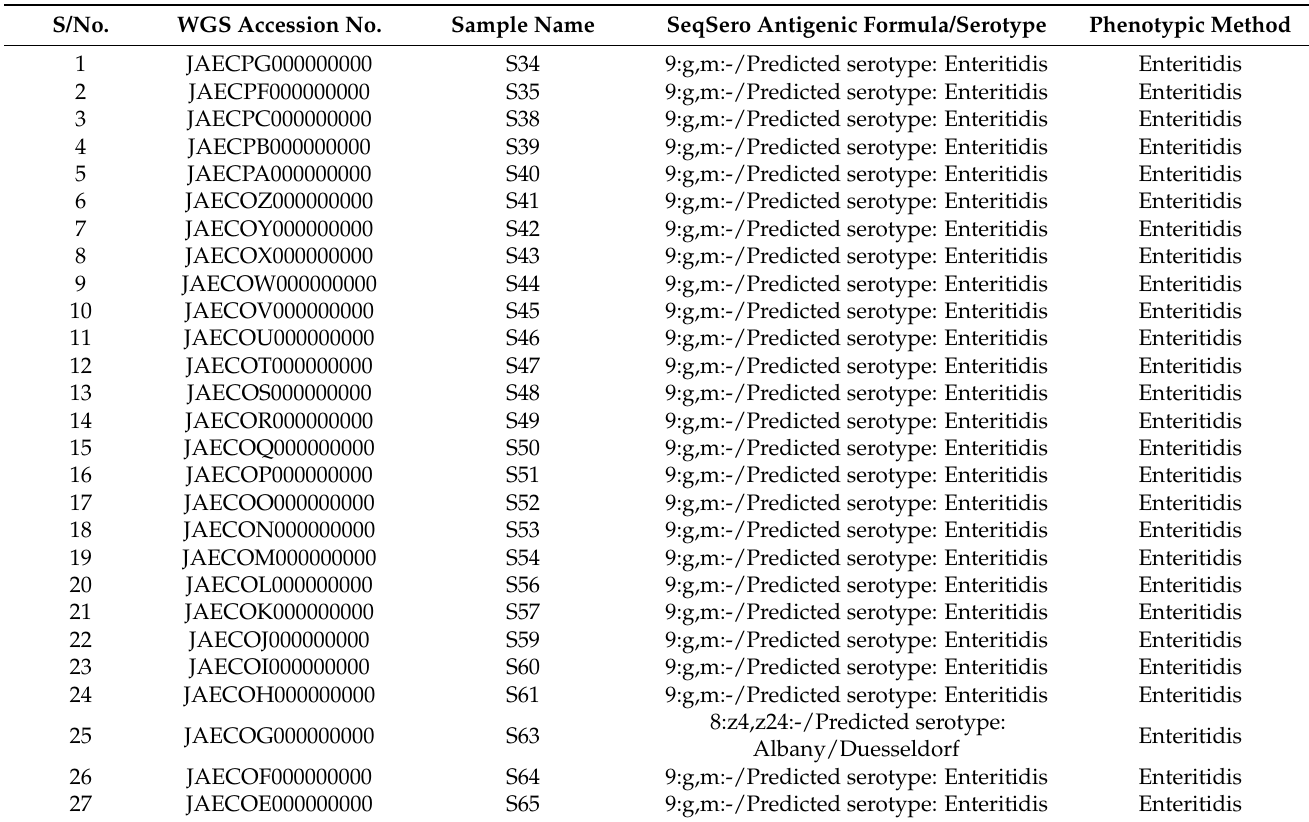
Table 2. In silico WGS and phenotypic Salmonella